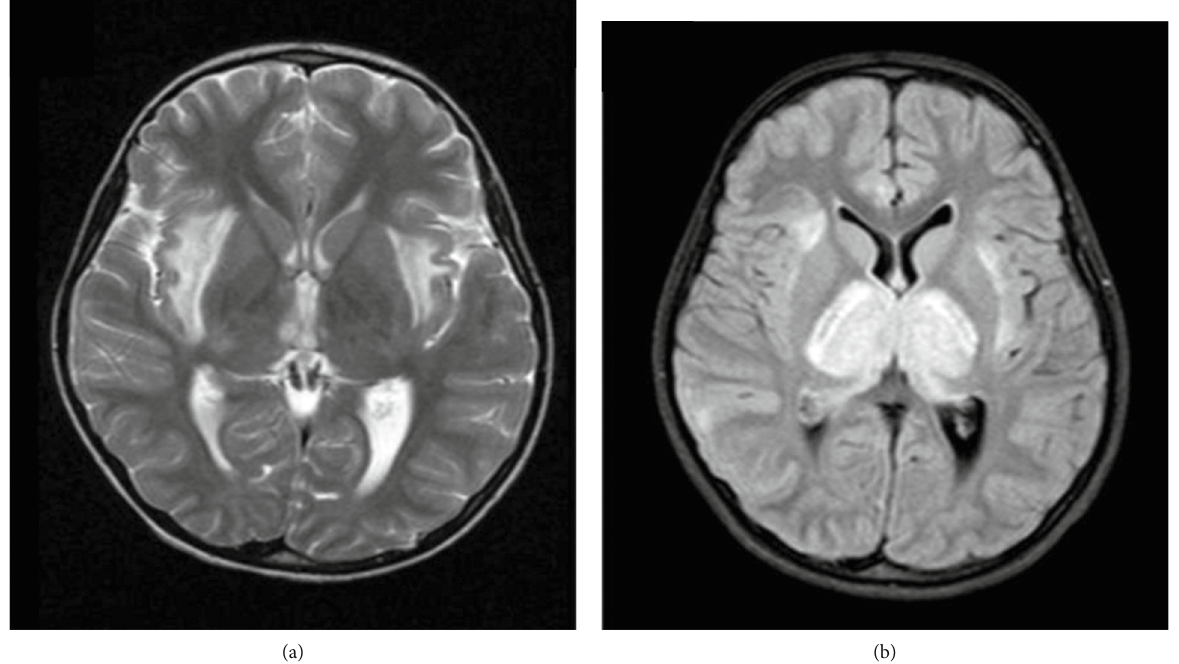
Figure 1: MRI images of case 1 at the (a) fi rst and the (b) second